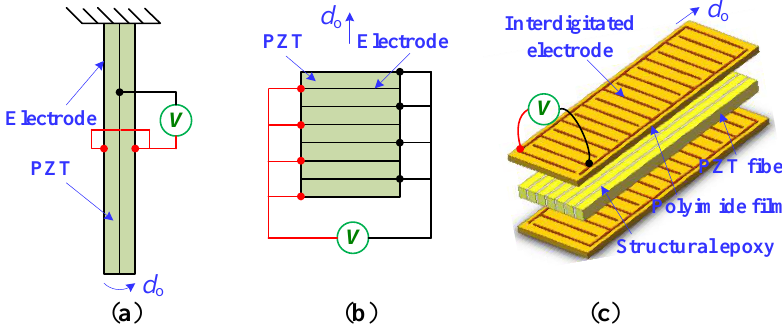
Figure 1. Schematic diagram of piezoelectric actuators: ( a ) the PBA; ( b ) the PSA, and ( c ) the MFC actuator.